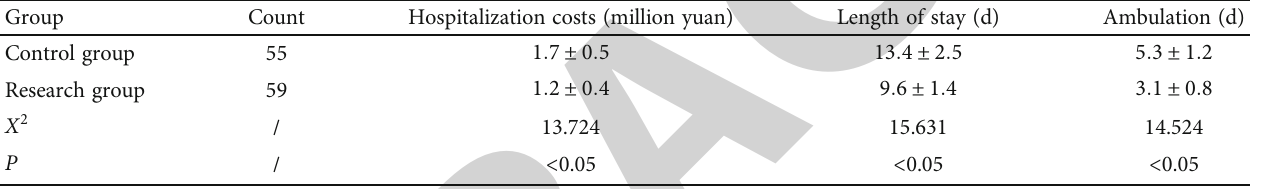
Table 3: Comparison of surgery results in two groups